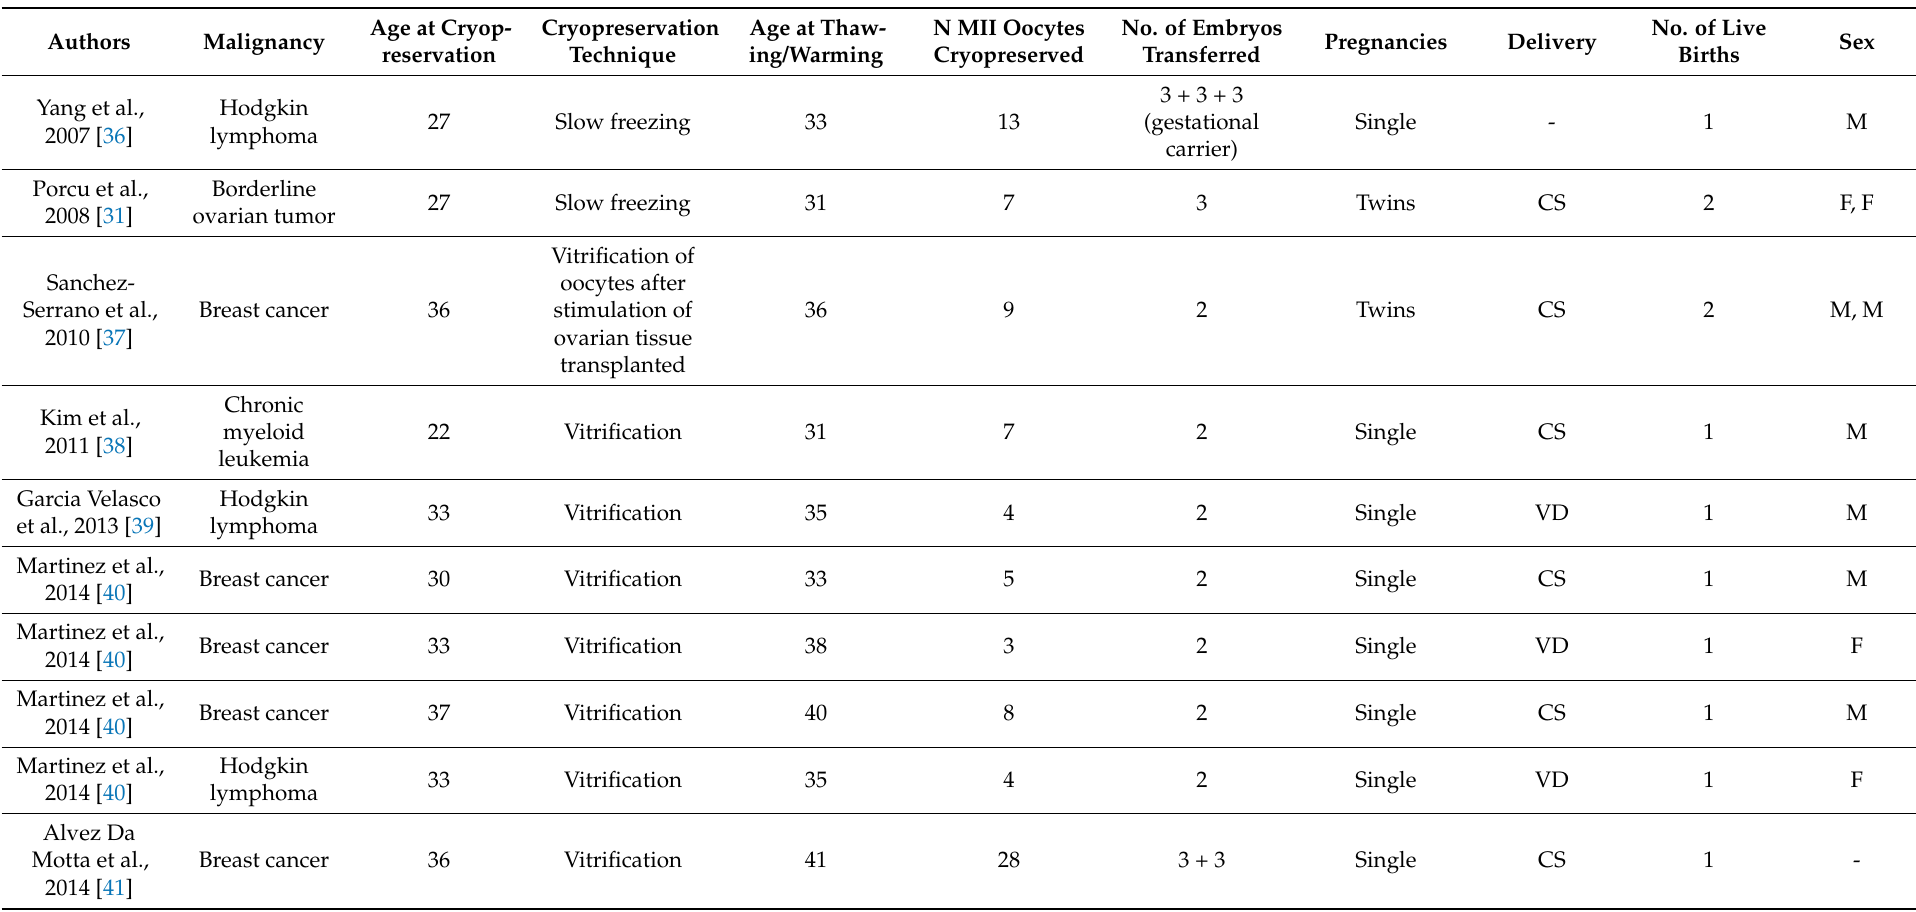
Table 6. Live birth case reports of the literature in cancer patients who preserved fertility through oocyte